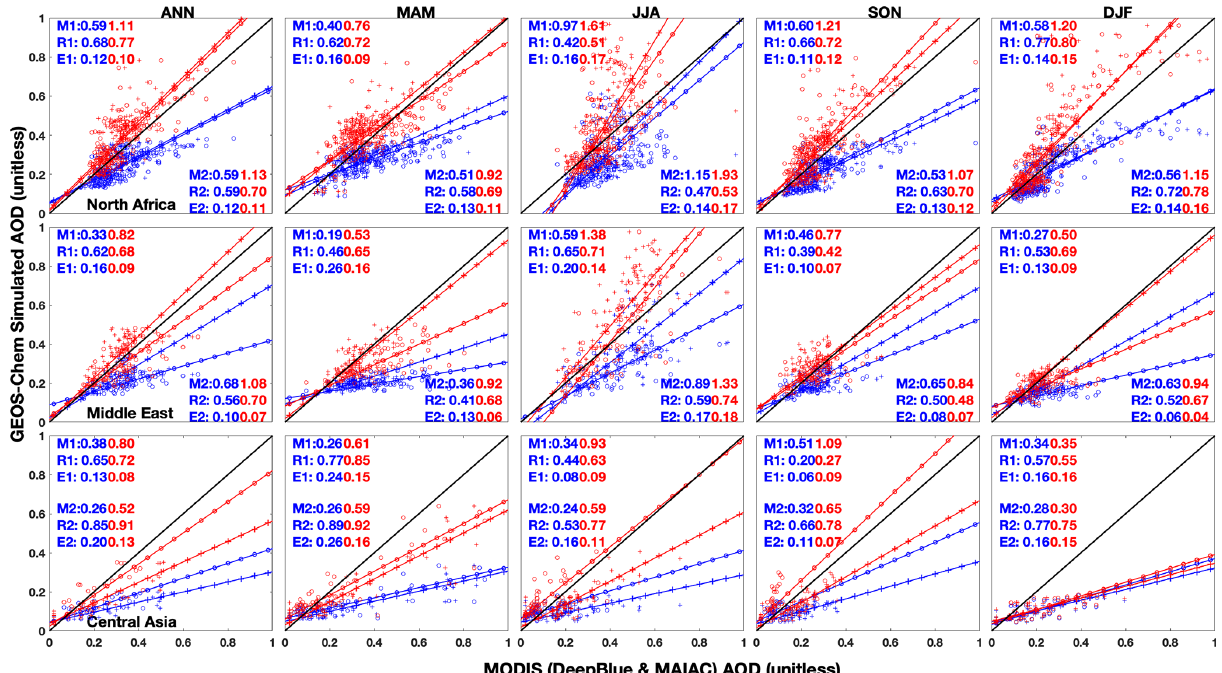
Figure 4. Scatter plots and statistics of comparing GEOS-Chem simulated AOD with satellite AOD over desert regions annually (the first column) and seasonally (the right four columns). The results for the North African, Middle Eastern and central Asian deserts are shown in the top, middle and bottom rows, respectively. The results for the simulation using the original dust emissions are shown in blue; the results for the simulation using updated dust emissions with dust strength of 2000Tgyr − 1 are shown in red. Open circles represent the comparison with MODIS Deep Blue AOD; the plus signs represent the comparison with MAIAC AOD. Correlation coefficient ( R ), root mean square error ( E ) and slope ( M ) are reported, in which R1, E1 and M1 show the results of the comparison with MODIS Deep Blue AOD; R2, E2 and M2 show the results of the comparison with MAIAC AOD. The best-fit lines are dashed lines with corresponding marker signs and colors. The 1:1 line solid black